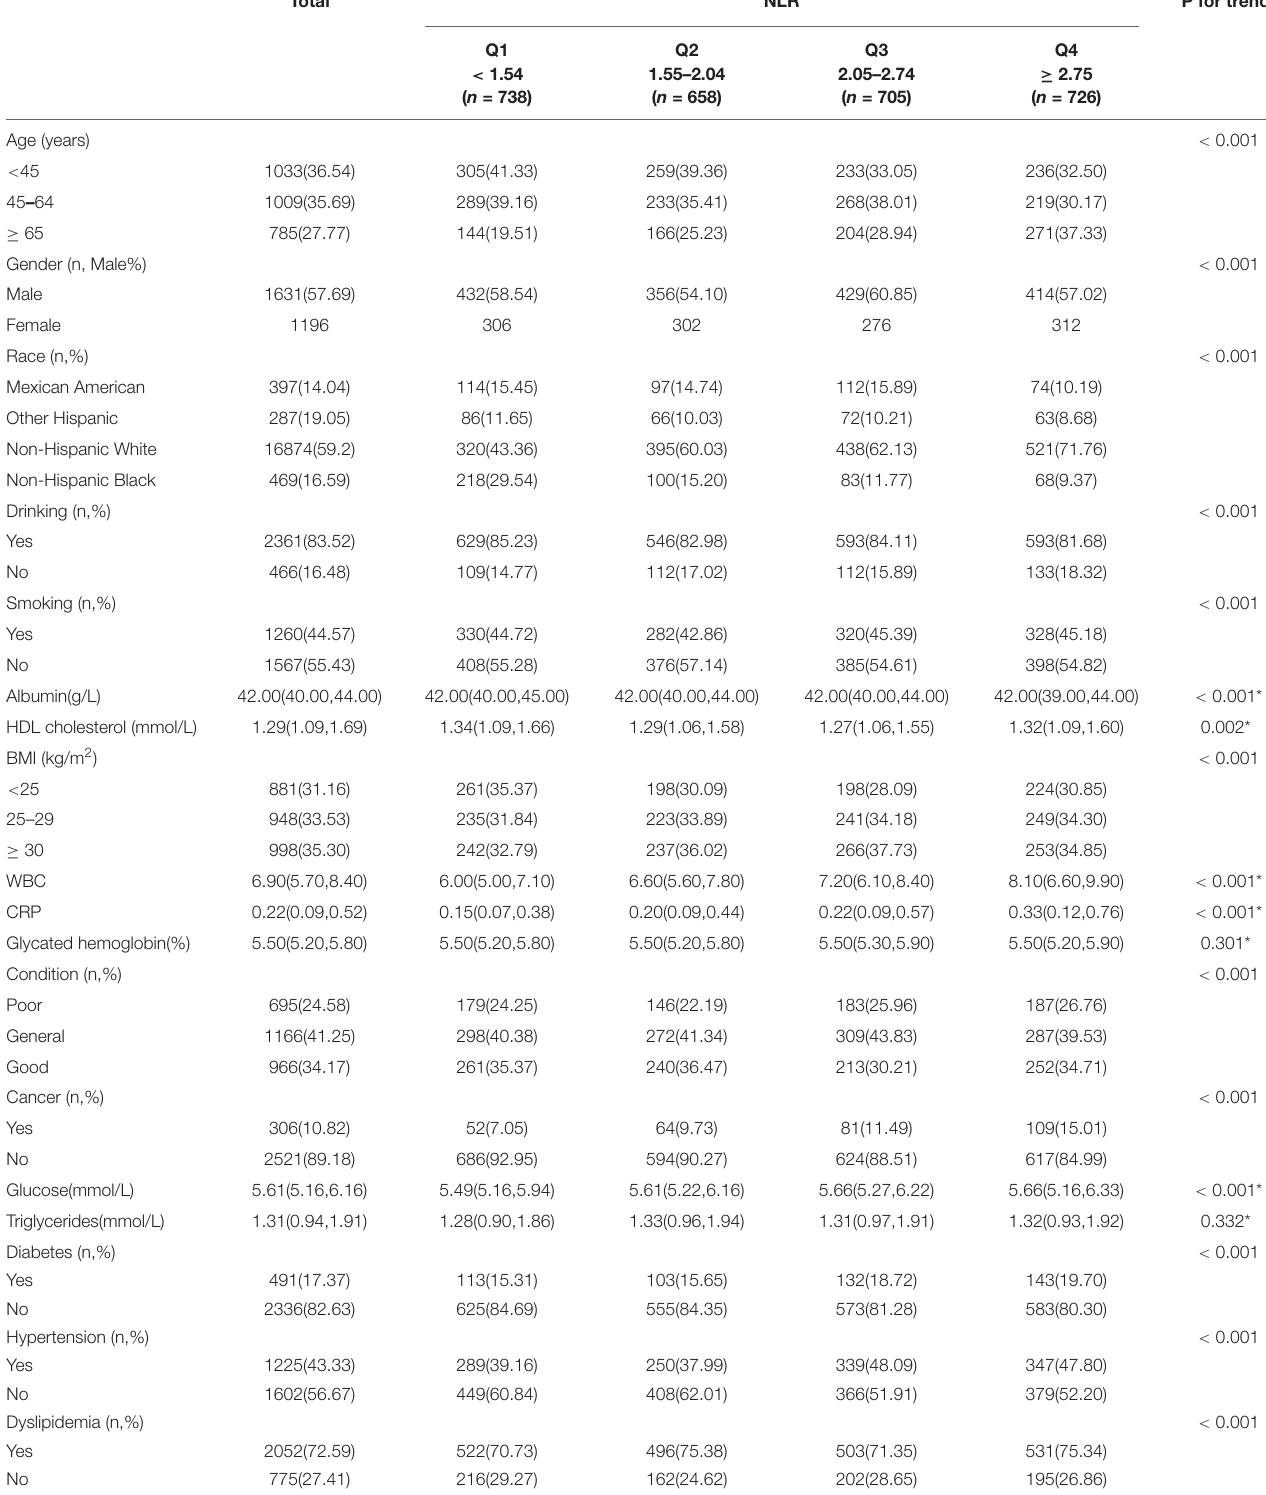
TABLE 1 | Demographic and clinic characteristics according to NLR